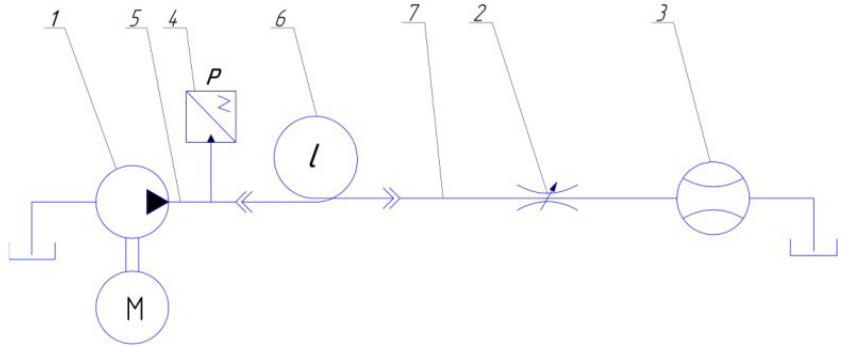
Figure 21. ISO 1219 scheme of the bench system implementing a non-reflective load at the liquid output from the pump: 1—pump, 2—load throttle, 3—flow sensor, 4—pressure sensor, 5 and 7—connecting lines and fittings and 6—“infinitely” long pipeline.